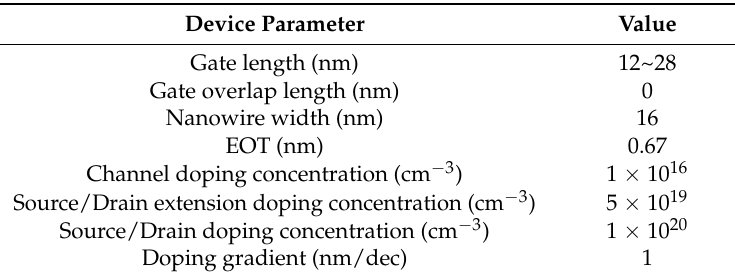
Figure 1. Schematic structure of GAA SNWTs with three cross-sectional shapes used in the simulation. Table 1. Device parameters used in the simulation.